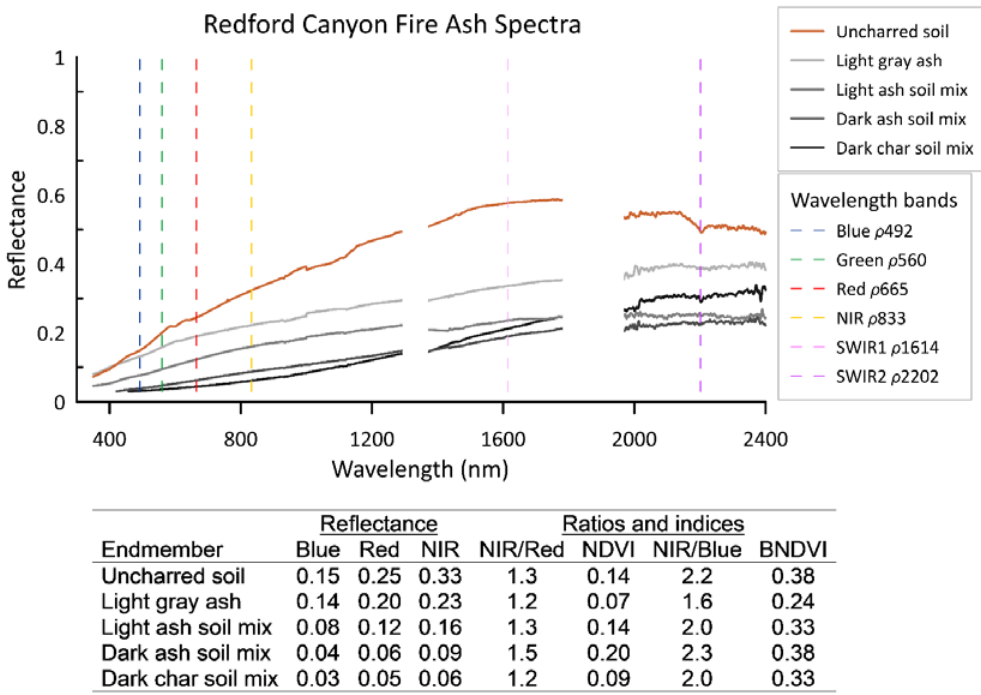
Figure 9. Endmember spectra of the range of uncharred soil and gray ash, and soil, ash, char mixes from the Redford Canyon Fire. Blue reflectance is centered at p492 nm (corresponding to S2 band 2); red is at p665 nm (S2 band 4); and NIR is at p833 nm (S2 band 8a) from the Redford Canyon field spectra. Several wavebands around 1400 and 1900 nm were removed for atmospheric scattering noise.